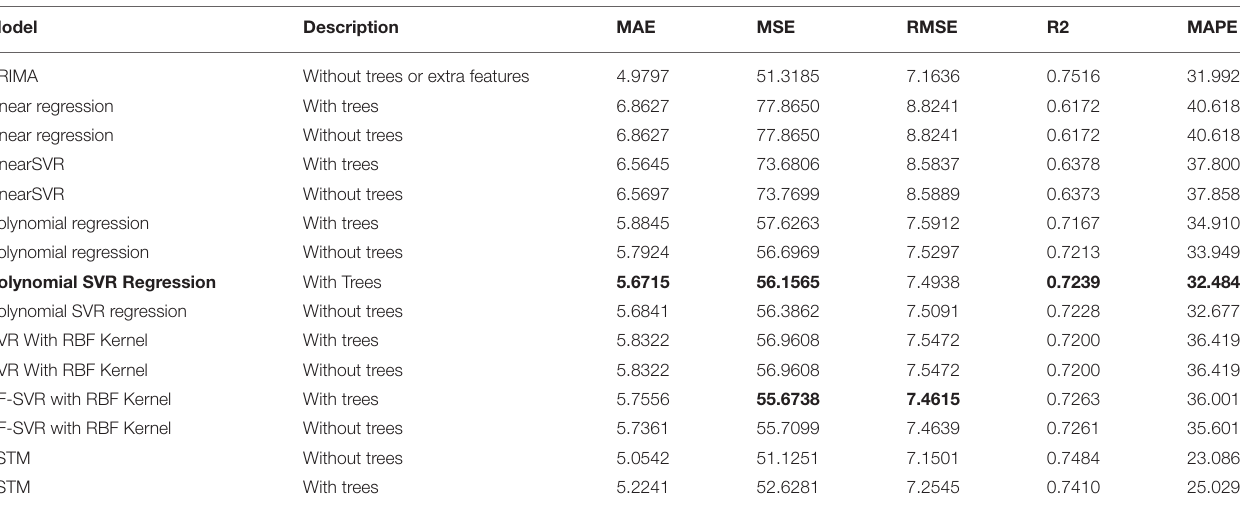
TABLE 7 | Experimental results for NO2, location-2, Gonville